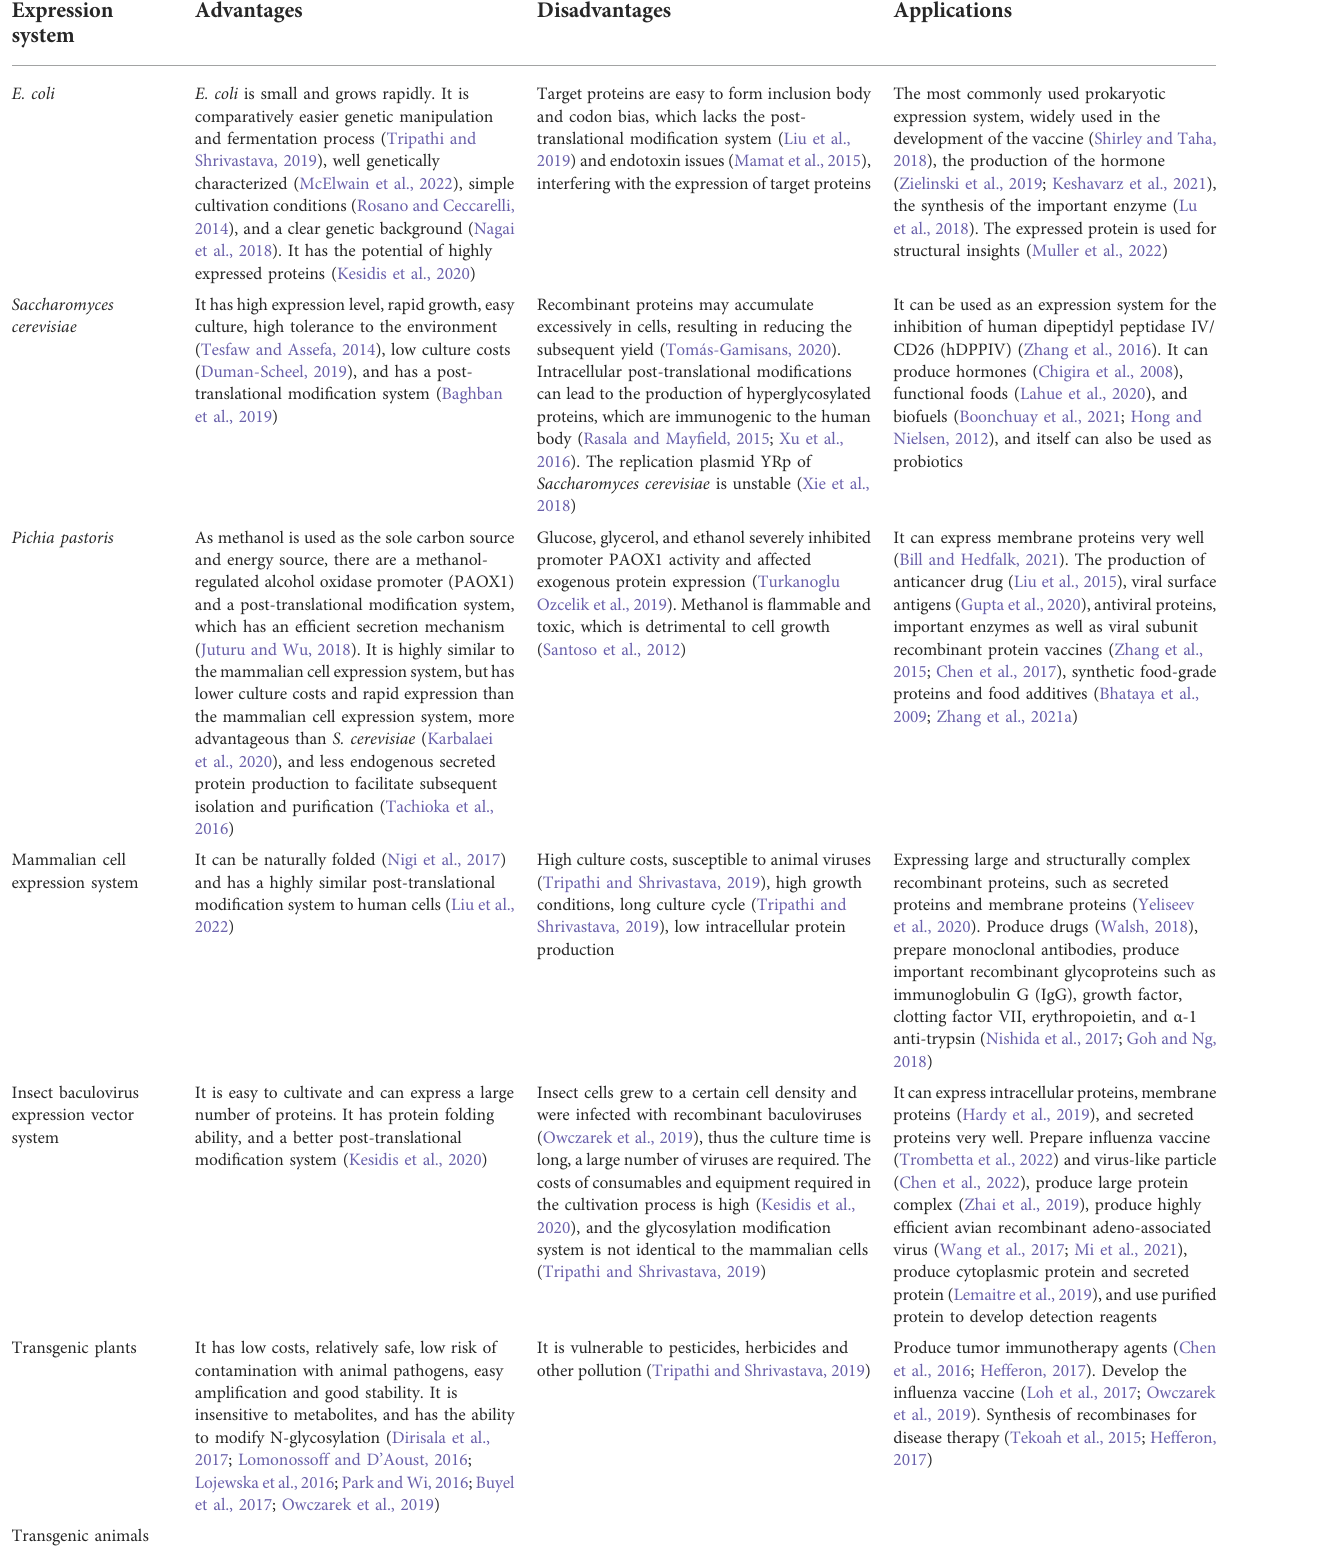
TABLE 1 Characteristics and applications of different expressed